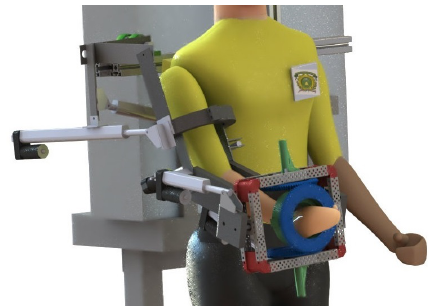
Figure 3. Conceptual model of ERMIS.